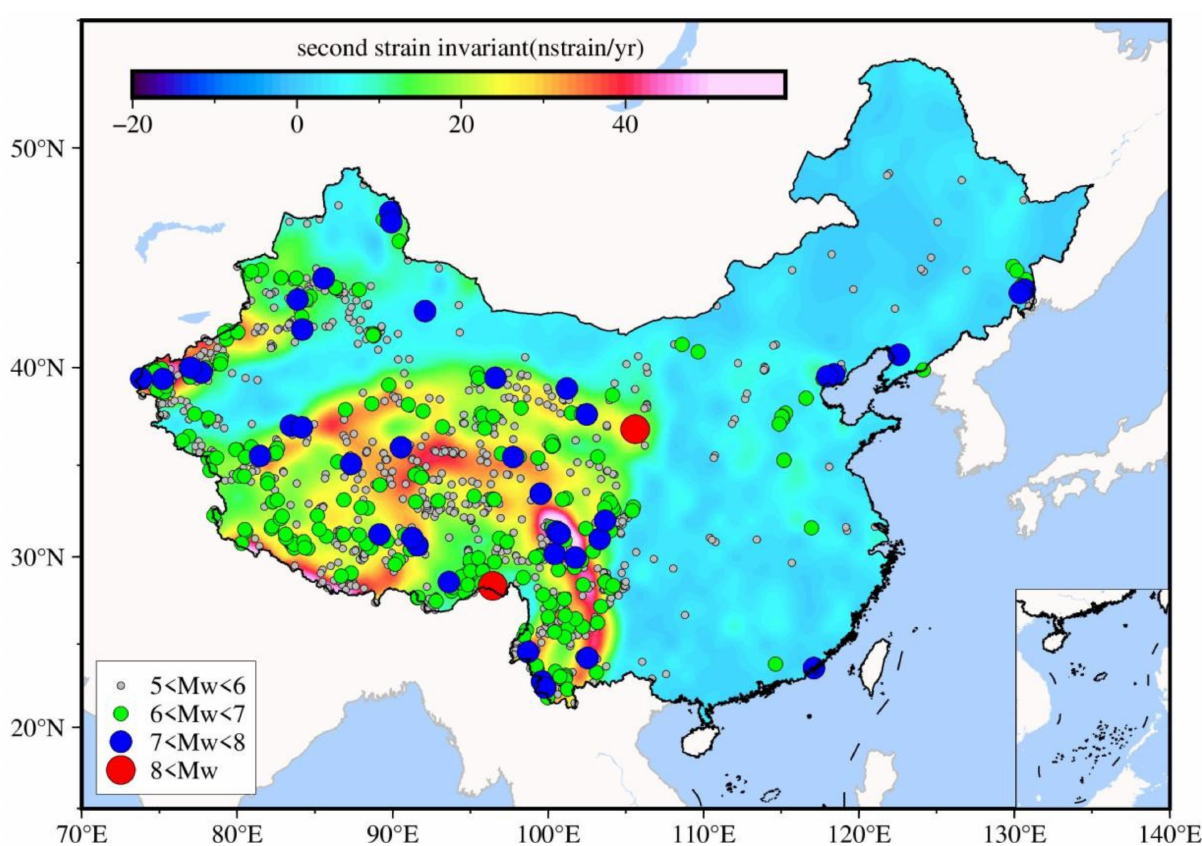
Figure 10. The distribution of strong earthquake and second strain invariant